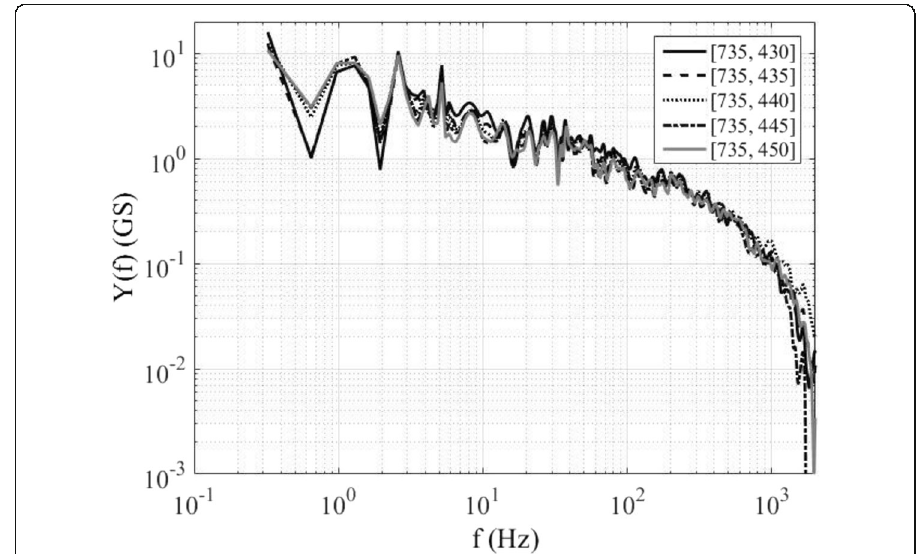
“ getpts, ” determines the pixel coordinates at the location clicked by the user. Only the ver- tical coordinate is used. It is paired with all horizontal, i, pixel location coordinates, creat- ing a horizontal line of pixels. Figure 8 shows a white horizontal line at the selected vertical pixel coordinate from data obtained on 05 April 2018.